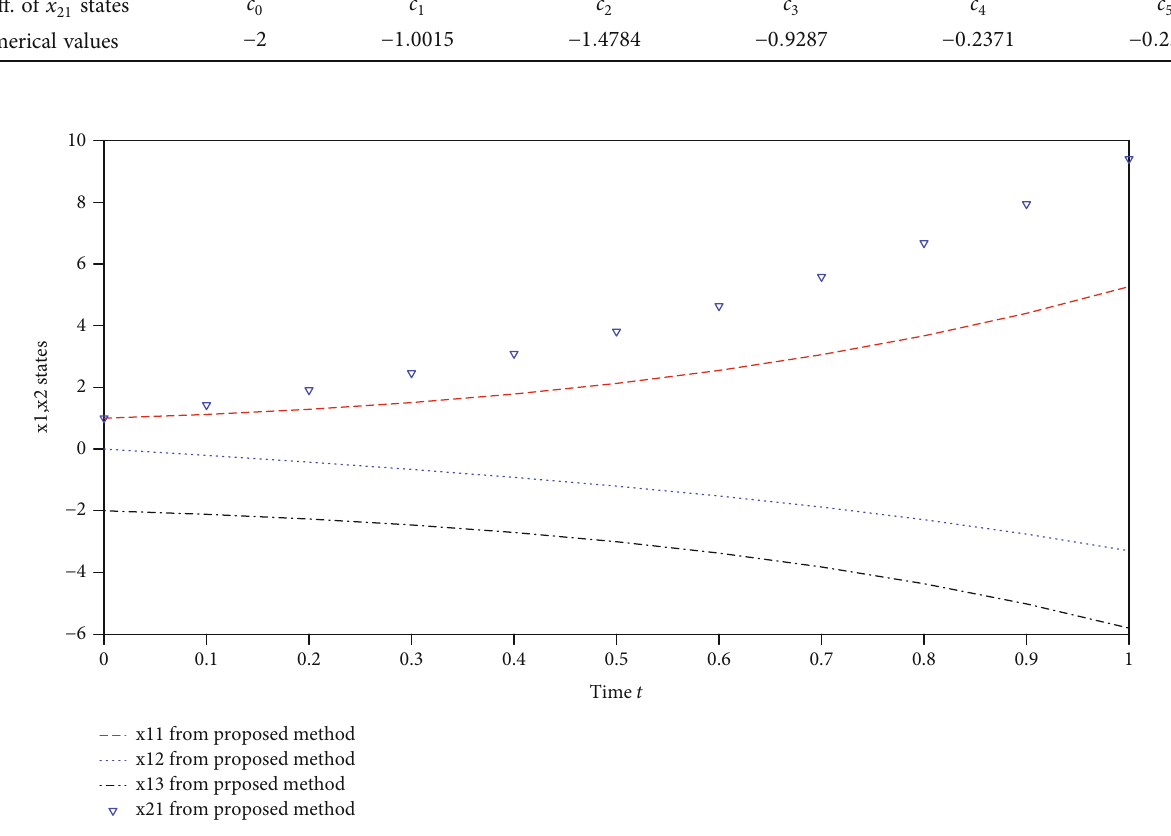
Figure 3: Comparisons between the proposed approach and the exact